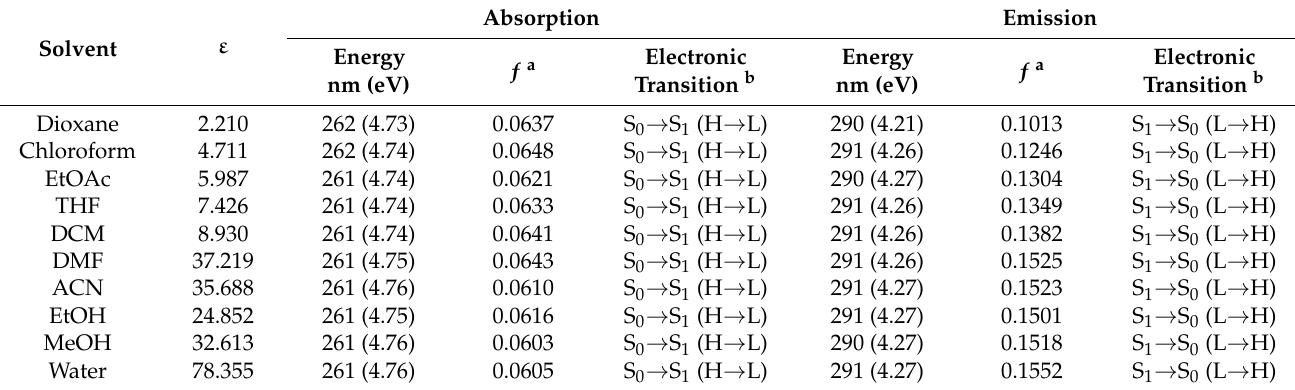
Table 4. Calculated UV–Vis absorption and fluorescence emission for the benzoxazine (I) in different solvents.